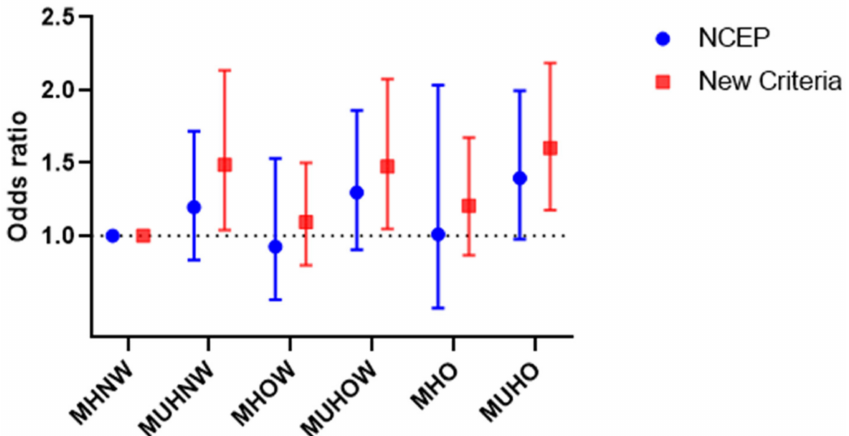
Figure 3. Risk of carotid atherosclerosis in subgroups of body mass index and metabolic health using the new definition (red square) and the National Cholesterol Education Program–Adult Treatment Panel III (NCEP-ATPIII) criteria (NCEP definition) (blue dot). Hazard ratios (95% CIs) adjusted for age, sex, HbA1c, TG, HDL-C, LDL-C, hsCRP, eGFR, HOMA-IR, smoking status, alcohol consumption, physical activity, and the corresponding other definition of metabolic health. Abbreviations: CI, confidence interval; HbA1c, hemoglobin A1c; TG, triglyceride; HDL-C, high-density lipoprotein cholesterol; LDL-C, low-density lipoprotein cholesterol; hs-CRP, high-sensitivity C-reactive protein; eGFR, estimated glomerular filtration rate; HOMA-IR, homeostatic model assessment of insulin resistance; MHNW, metabolically healthy normal weight; MUHNW, metabolically unhealthy normal weight; MHOW, metabolically healthy overweight; MUHOW, metabolically unhealthy overweight; MHO, metabolically healthy obese; MUHO, metabolically unhealthy obese.